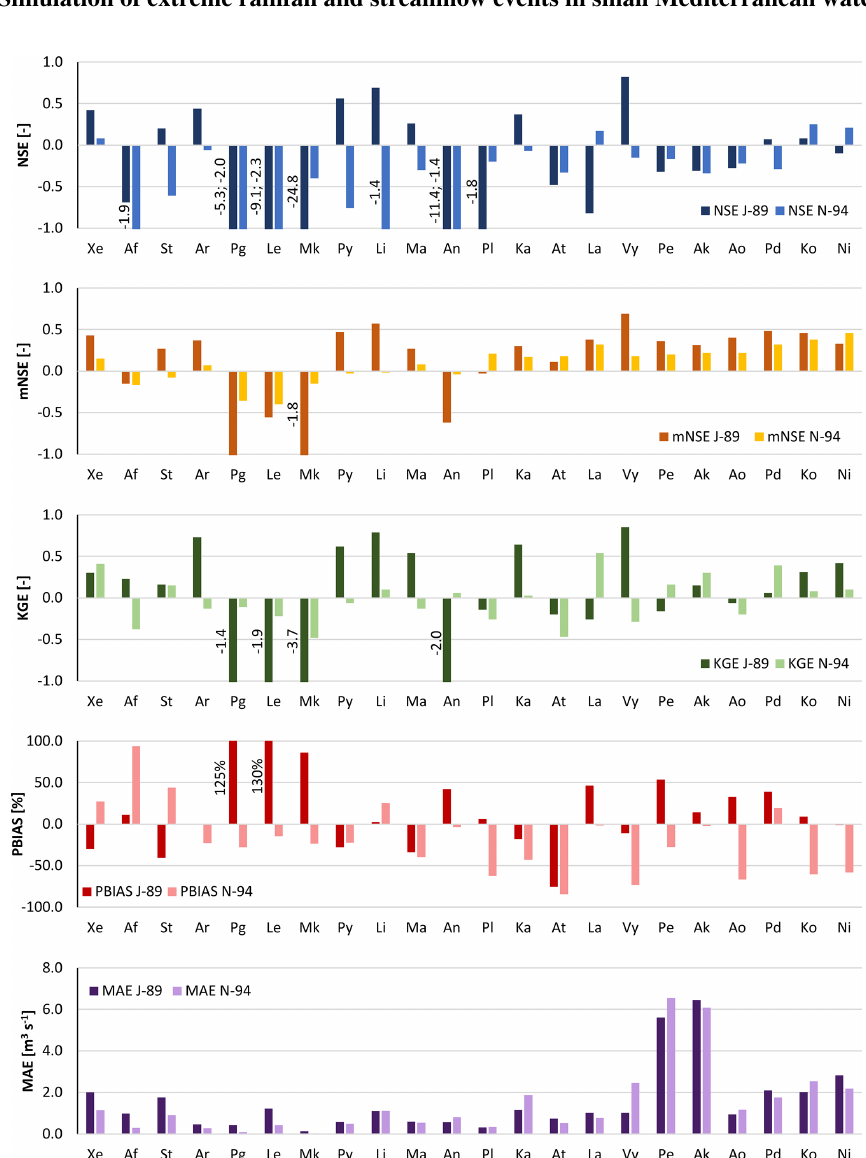
Figure 9. Performance indices (NSE, Nash–Sutcliffe efficiency; mNSE, modified Nash–Sutcliffe efficiency; KGE, Kling–Gupta efficiency; BIAS; MAE, mean absolute error) calculated on daily streamflow resulting from WRF-modelled rainfall for the 22 watersheds using the calibrated set of parameters for both the January 1989 (J-89) and November 1994 (N-94) events. For watershed abbreviations refer